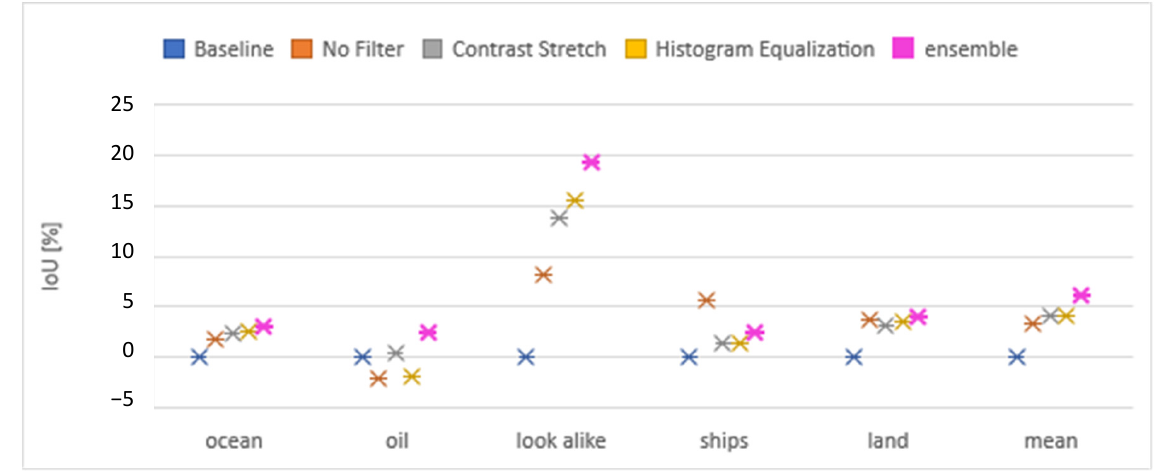
Figure 5. Improvement compared to baseline—Unet .